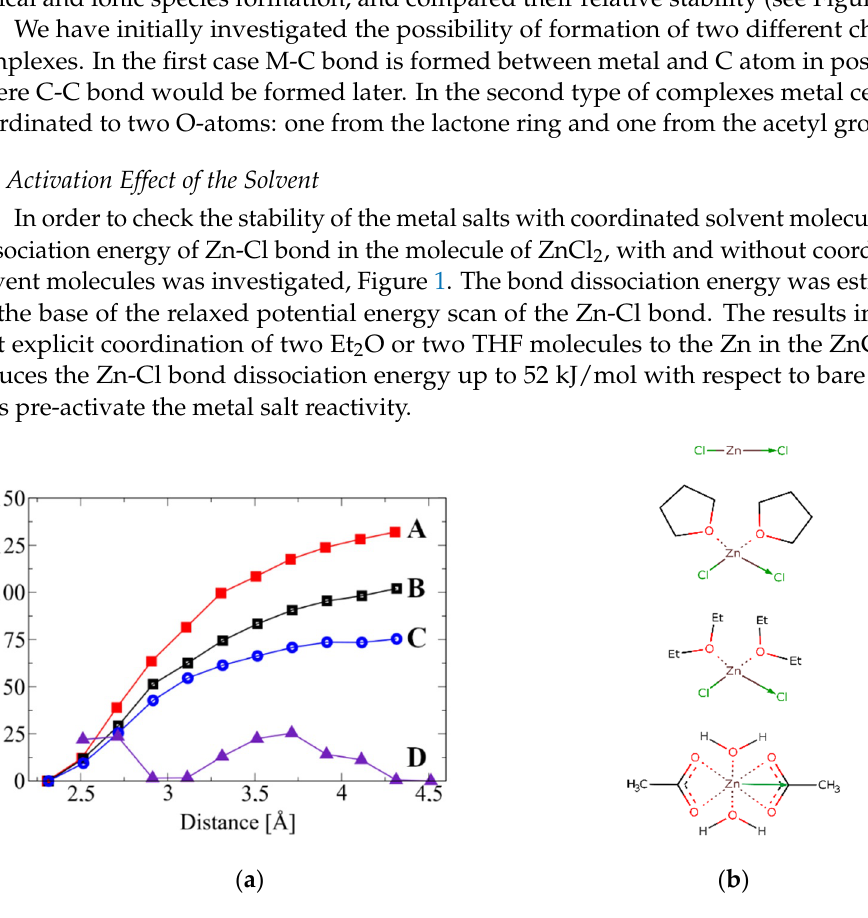
to the Zn ‐ Cl distance of ZnCl 2 and Zn ‐ carbonyl C ‐ atom of Zn(OAc) 2 × 2H 2 O: A —Zn ‐ Cl bond disso ‐ respect to the Zn-Cl distance of ZnCl 2 and Zn-carbonyl C-atom of Zn(OAc) 2 × 2H 2 O: A —Zn-Cl